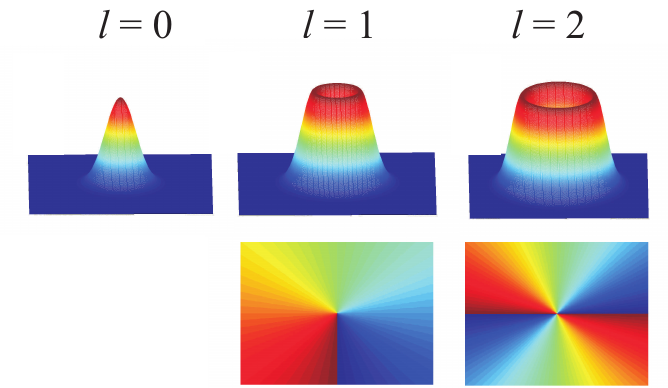
Figure 5. Plots of intensity (top row) and phase (bottom row) in the transverse plane for several LG modes with different l values, but with p = 0 in each case. For l = 0, the phase is constant in each plane; for l (cid:54) = 0, it increases linearly with angle as the axis is circled. The amplitude vanishes on the axis for the l (cid:54) = 0 cases, but is a maximum there for l = 0.